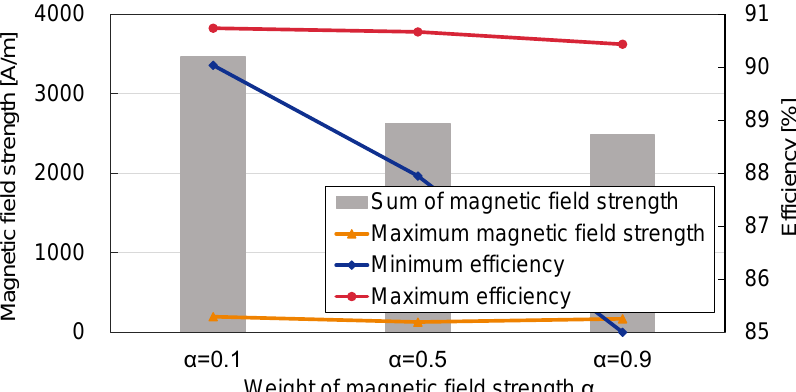
Figure 9. Effect of magnetic field strength weight α on the transmission efficiency and magnetic field suppression for 5